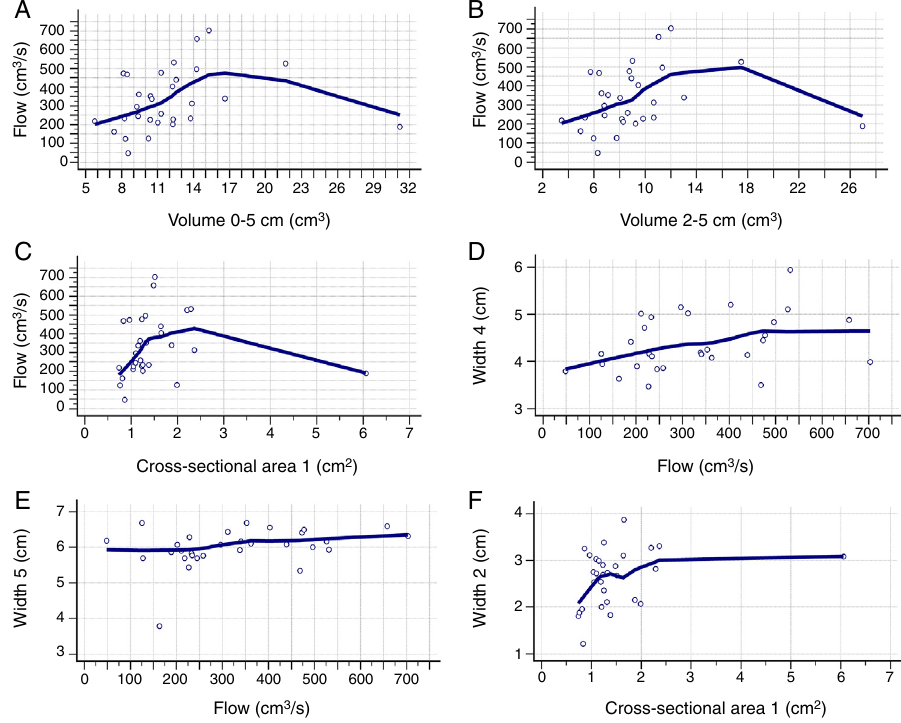
Figure 2 Positive correlation between the data obtained in the acoustic rhinometry, computed rhinomanometry and cone-beam computed tomography. A, Correlation between flow of computed rhinomanometry and nasal volume of 0---5 cm of acoustic rhinome- try. (Rho = 0.421; 95% CI = 0.072---0.679). B, Correlation between flow of computed rhinomanometry with the nasal volume of 2---5 of acoustic rhinometry (Rho = 0.393; 95% CI = 0.038---0.660). C, Correlation between flow of computed rhinomanometry and the mini- mum cross-sectional area 1 of acoustic rhinometry (Rho = 0.375; 95% IC = 0.017---0.648). D, Correlation between Width 4 of cone-beam computed tomography and flow of computed rhinomanometry (Rho = 0.380; 95% CI = 0.023---0.651). E, Correlation between Width 5 of cone-beam computed tomography and flow of computed rhinomanometry. (Rho = 0.371; 95% CI = 0.013---0.645). F, Correlation between Width 3 of cone-beam computed tomography and minimum cross-sectional area 1 of the acoustic rhinometry (Rho = 0.380; 95% CI = 0.022---0.651). Statistical analysis performed by Spearman’s correlation test. For the AR and CBCT correlation, there was a positive posterior crossbite and increased dental overjet in patients correlation between MCA1 evaluated without administra- with allergic rhinitis 1,22 ; (ii) highest prevalence of hard, nar- tion of vasoconstrictor and Width 2 (Rho = 0.380; 95% row, and high-arched palate 3,23 ; (iii) hypertrophic adenoids CI = 0.022---0.651) (Fig. 2F); Width 4 and nasal volumes with markedly convex facial profile 4 ; (iv) severe mouth breathing with changes in the nasolabial profile. 24 How- ever, in other reports, there was no correlation between mouth breathing and facial pattern or malocclusions.